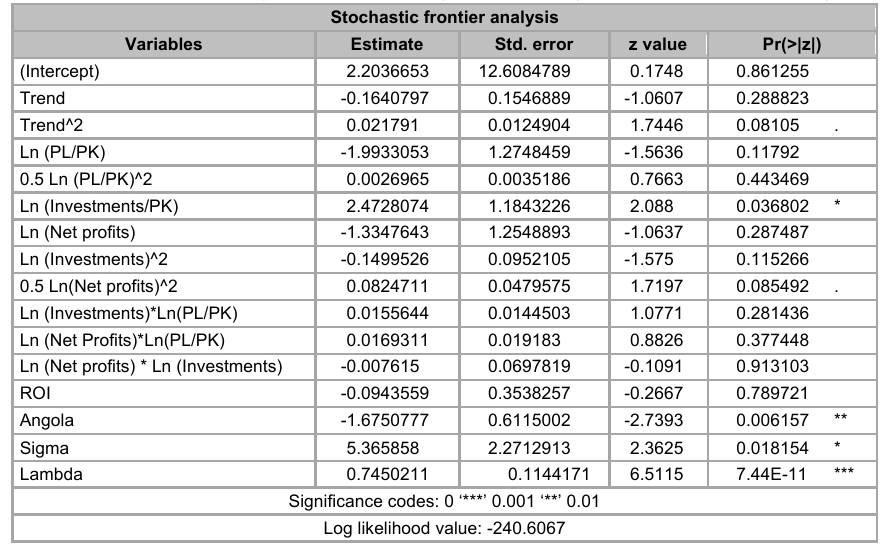
Stochastic frontier analysis results - translog cost function (dependent variable: Ln cost)